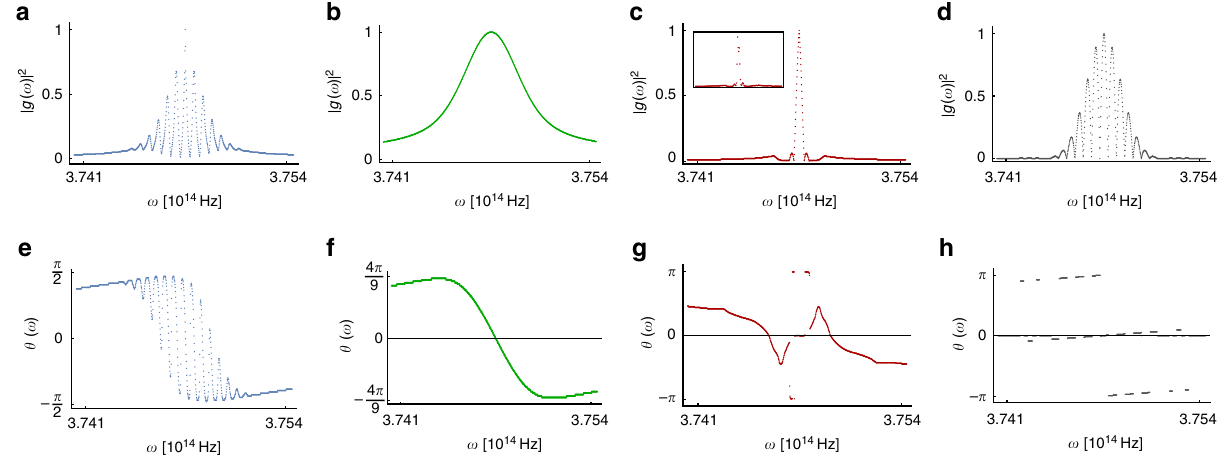
Fig. 3 Implemented photon frequency and phase distributions. a – d Probability distributions | g ( ω )| 2 of the photon frequency. a – c correspond to spin – Ising model simulation and ( d ) corresponds to nonpositive map simulation. Inset in panel ( c ) shows the experimentally measured distribution for this case after the SLM implementation. e – h Phase distributions θ ( ω ) of the photon frequency corresponding to ( a – d ). These distributions were implemented pairwise in the experiment with a two-dimensional SLM using the effective resolution of 900 pixels in frequency modes. The bandwidth of each distribution is approximately 3 nm and they are centered at 800 nm. The measurement data of the simulator dynamics corresponding to implemented distribution pairs (a, e), (b, f), (c, g), and (d, h) are shown in Fig. 2(e – h),